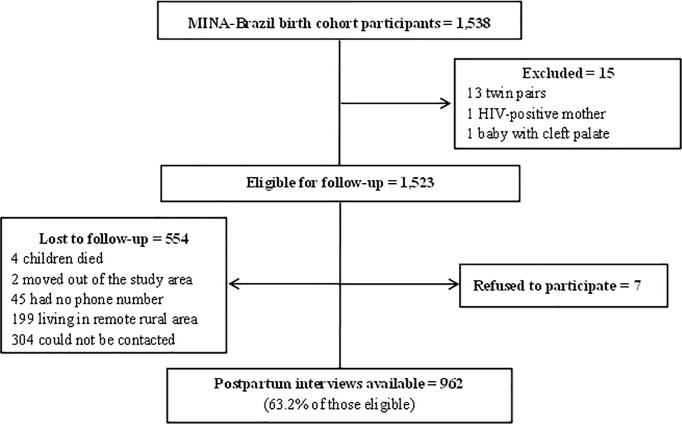
Flow chart of participants in the MINA-Brazil birth cohort study for analysis of exclusive breastfeeding practice during the first month of life.